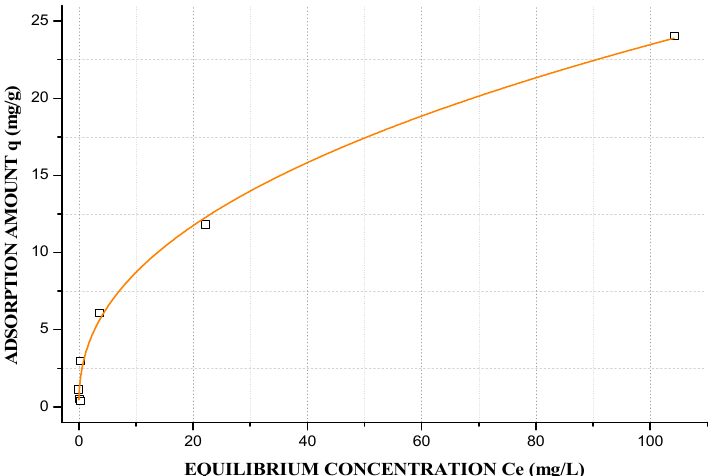
Figure 10. Influence of initial concentration on geopolymers adsorption capacity of Pb 2 + : m = 0.15 g, V = 40 mL, pH = 4.